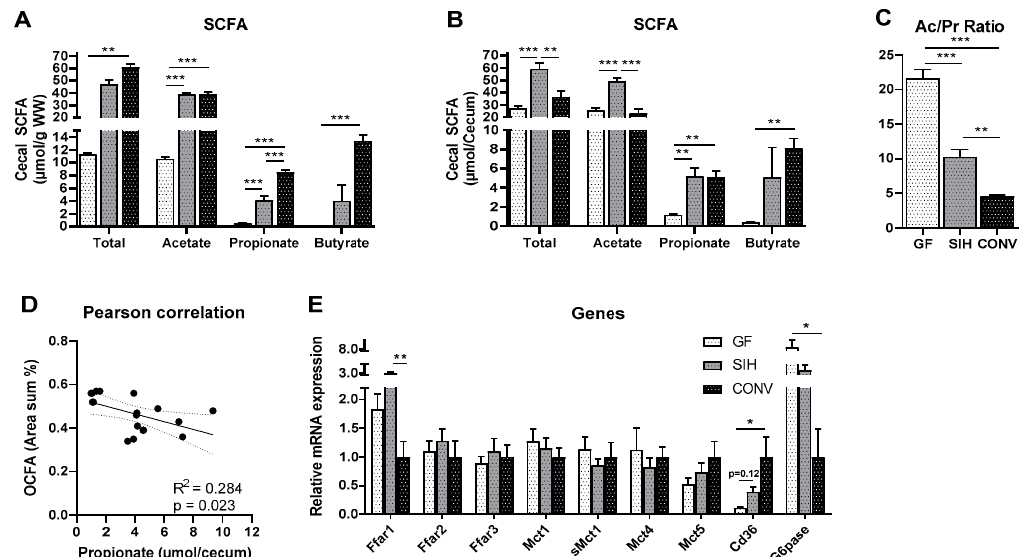
Figure 3. Conventional mice (CONV) on the CHOW diet have higher cecal propionate concentrations than germ-free mice (GF) and SIHUMI mice (SIH). Twenty-week-old male C3H/HeOuJ mice on CHOW diet (Altromin fortified 1314) harboring a germ-free (GF), simplified human (SIH) or conventional (CONV) microbiota: ( A , B ) short-chain fatty acid (SCFA) concentration in cecum and ( C ) the respective acetate/propionate ration (Ac/Pr). ( D ) Pearson correlation of cecal propionate concentration with hepatic odd-chain fatty acids (OCFA; C15:0 + C17:0) levels is shown. ( E ) mRNA expression in colon mucosa of genes involved in SCFA signaling, transport and intestinal gluconeogenesis. Data are mean + SEM ( n = 4–6) and expression data were normalized to the CONV group. Rpl13a was used as the housekeeping gene. * p < 0.05; ** p < 0.01; *** p < 0.001.